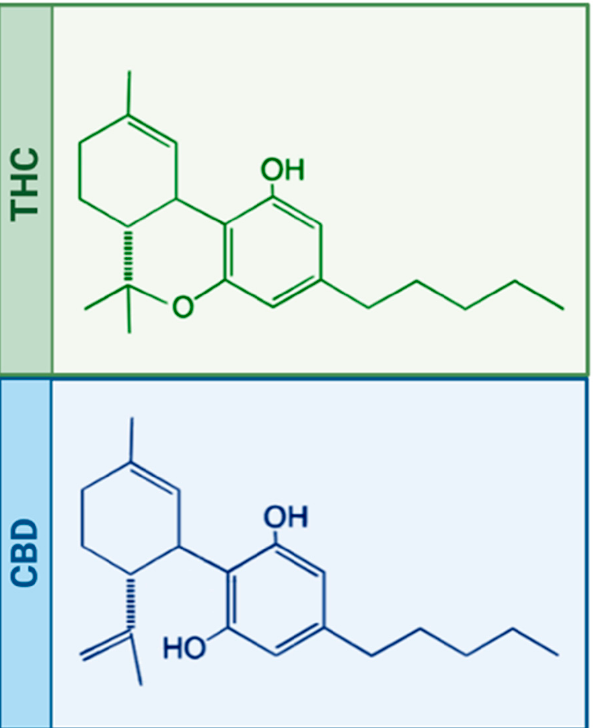
Figure 1. Chemical structures of Δ 9-tetrahydrocannabinol (THC) (green panel) and cannabidiol (CBD) (blue panel).